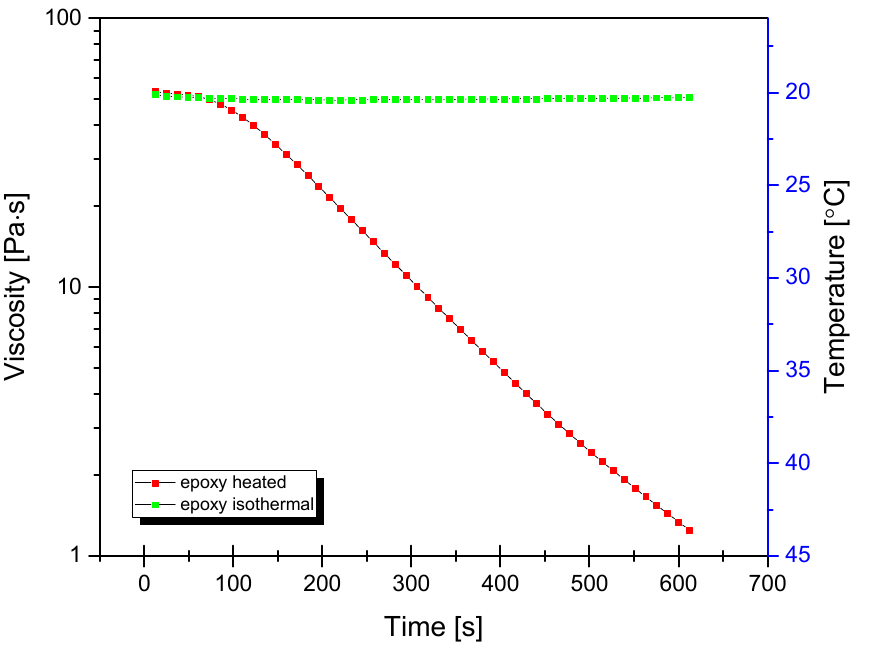
Figure 2. Dynamic viscosity curves of neat epoxy under isothermal and non-isothermal conditions under constant shear rate of 100/s.